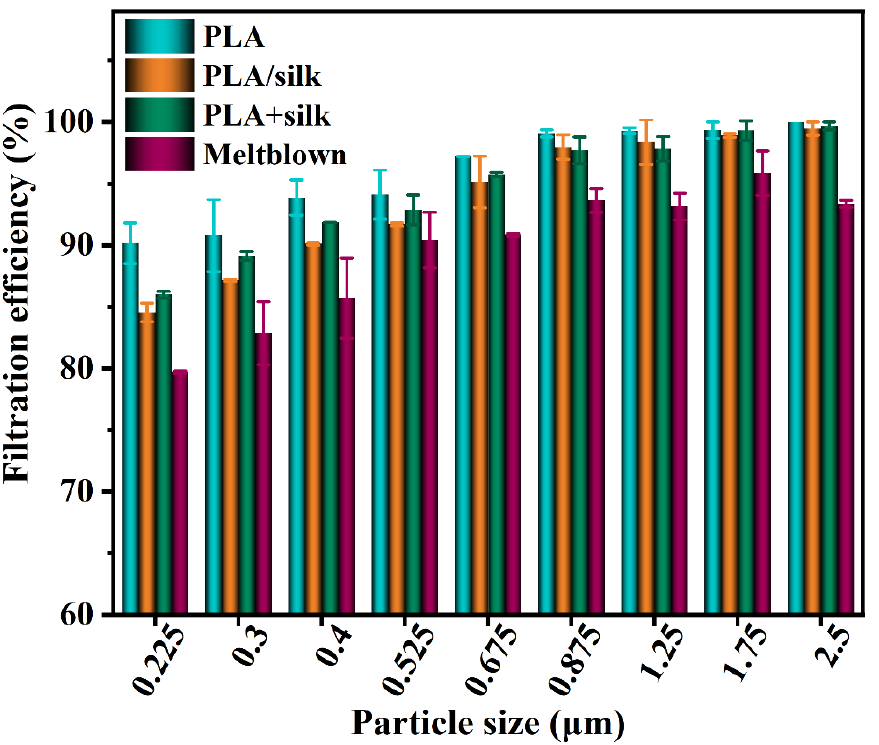
Figure 7. Filtration efficiency of electrospinning film (PLA), PLA/silk, PLA+silk, and melt-blown samples. Table 5. The electrostatic attenuation data of